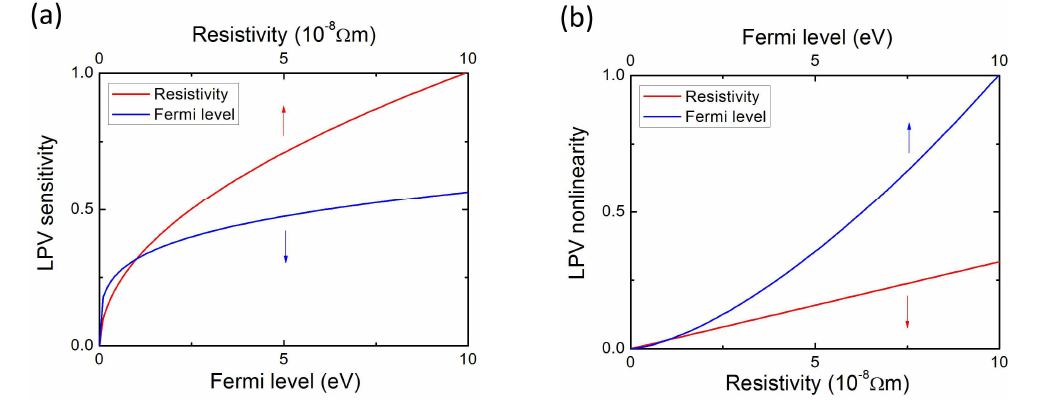
Figure 18. Calculation of normalized (a) LPV sensitivity and (b) nonlinearity responding to metal Fermi level and metal resistivity in MS structure according to Equation (21) and Equation